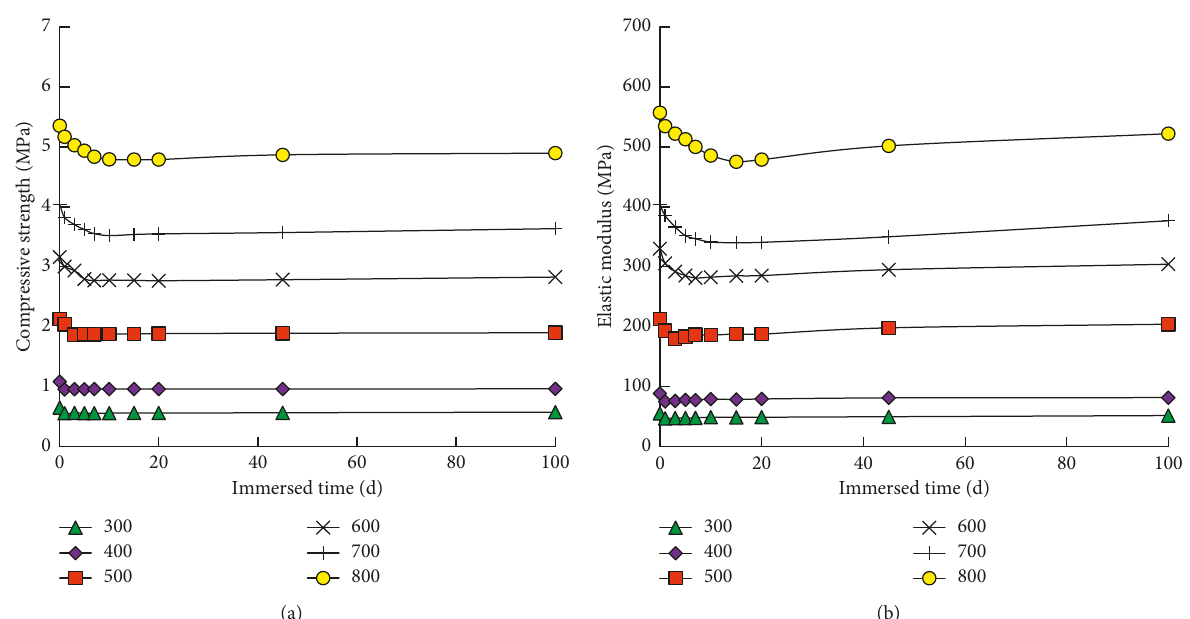
Figure 11: Effect of immersion time on (a) compressive strength and (b) elastic modulus (the water-level unchanged